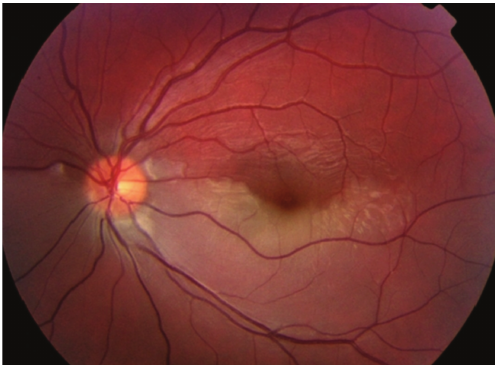
Figure 1: Colour photograph of left fundus at presentation, show- ing acute left hemiretinal artery occlusion and associated retinal oedema.